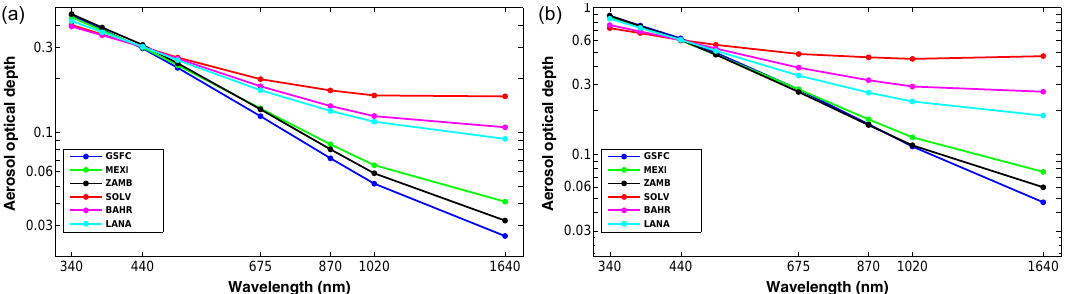
Figure 2. Spectral dependency of aerosol optical depth values of the six aerosol models represented in logarithmic scale for the cases with τ a ( 440 ) = 0 . 3 (a) and τ a ( 440 ) = 0 . 6 (b) .